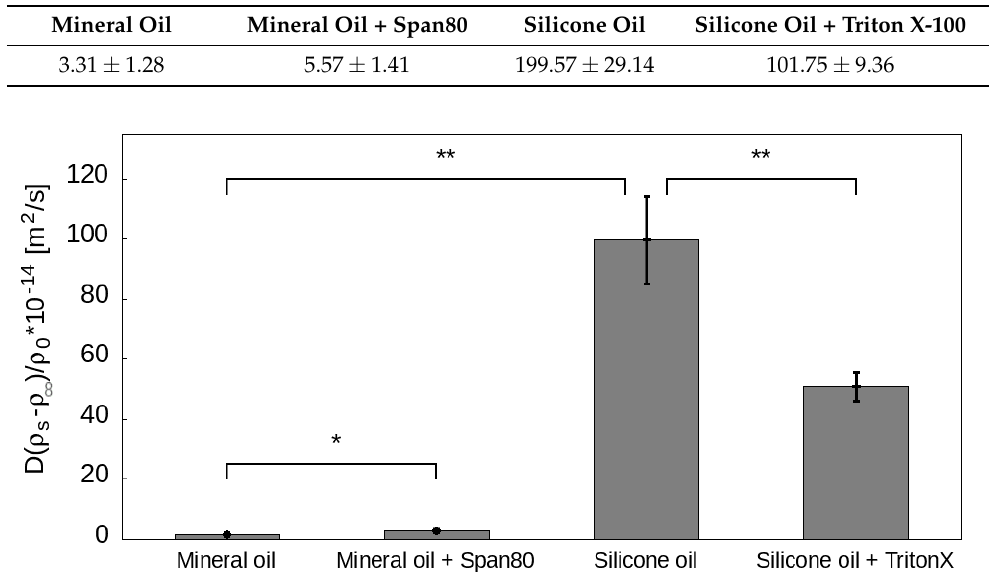
Figure 7. Values of D ( ρ s − ρ ∞ ) / ρ 0 of the four different oil mixtures we investigated in depth. For each material the data shown corresponds to a linear fit of five different droplets under the same conditions. Errors were calculated as the standard deviation of the five slopes. Significance levels: **: p < 0.01%, *: p < 0.05%. Values of D ( ρ s − ρ ∞ ) / ρ 0 are the following. Mineral oil: ( 3.31 ± 1.28 ) × 10 − 14 m 2 /s; mineral oil with 0.5 ( vol% ) Span80: ( 5.57 ± 1.41 ) × 10 − 14 m 2 /s; silicone oil: ( 199.57 ± 29.14 ) × 10 − 14 m 2 /s;